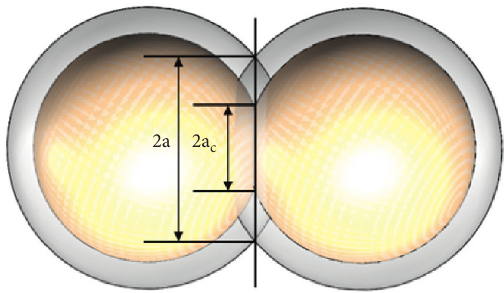
Figure 4: Contact between particles of JKR model [42].